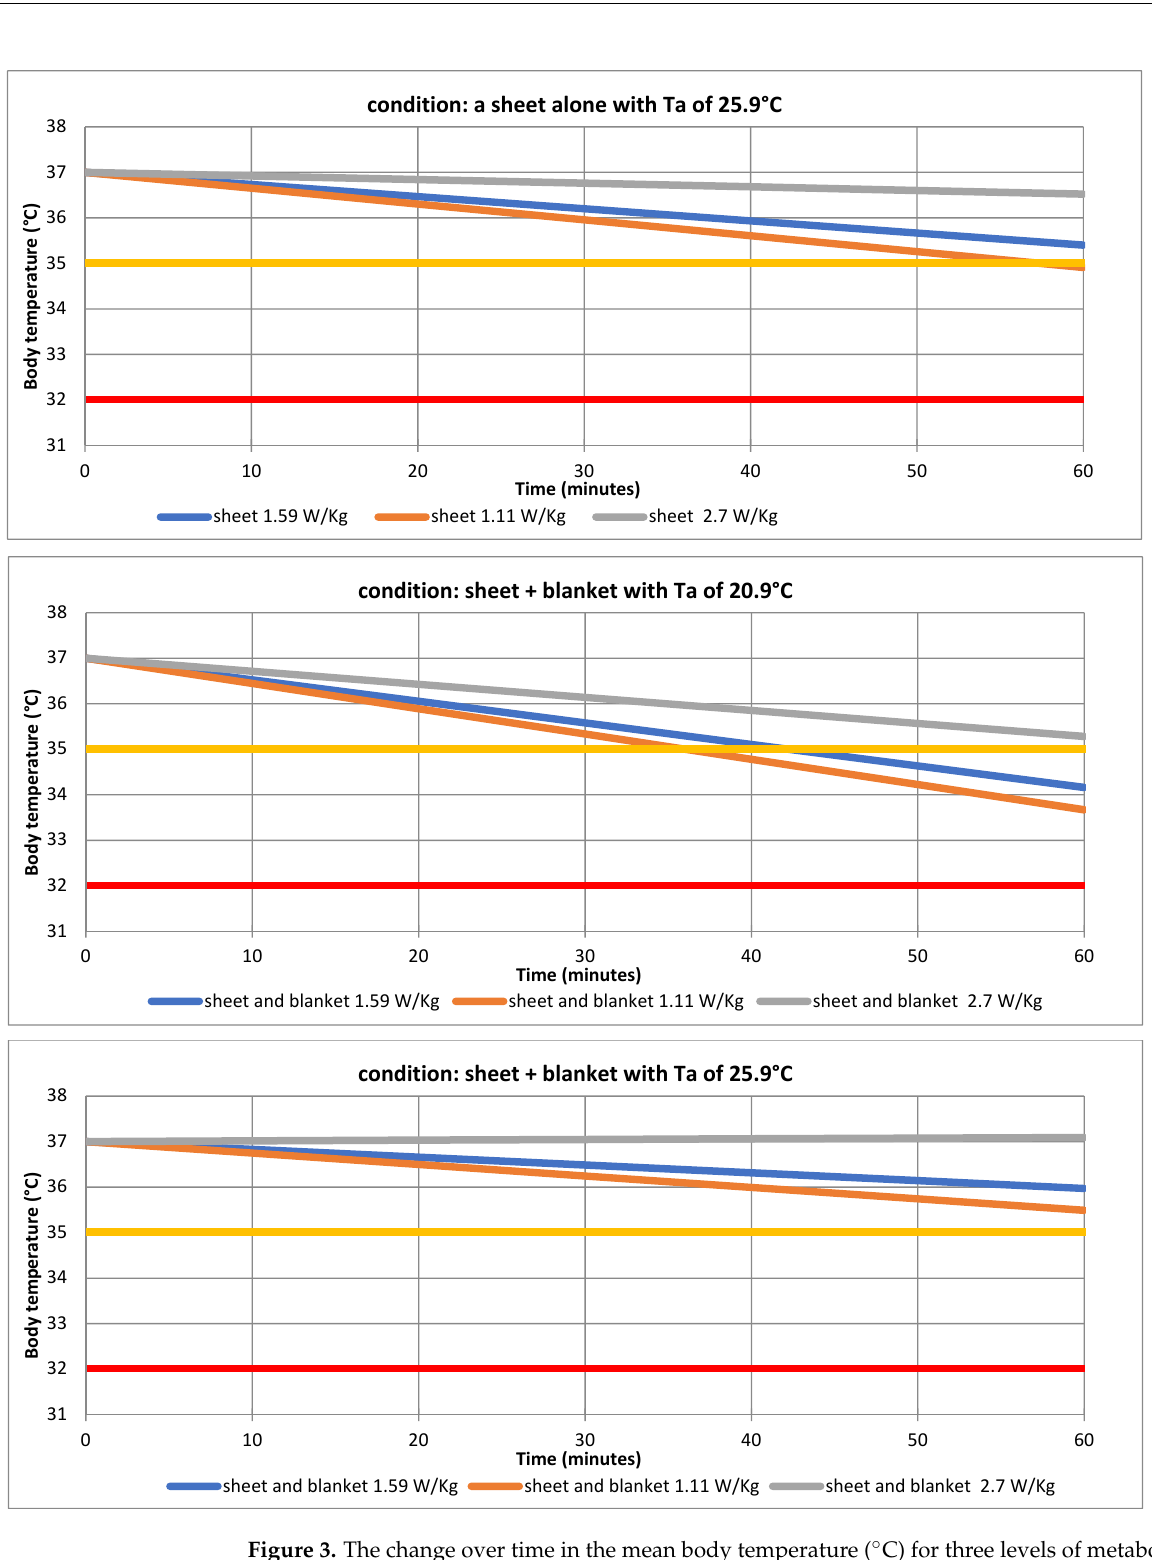
Figure 3. The change over time in the mean body temperature (°C) for three levels of metabolic heat generation (colored lines) at a T a of 20.9 or 25.9 °C and for the two thermal insulation conditions of (a sheet alone or sheet + blanket). The horizontal yellow and red lines indicate the thresholds for moderate hypothermia (35 °C), and severe hypothermia (32 °C), respectively.